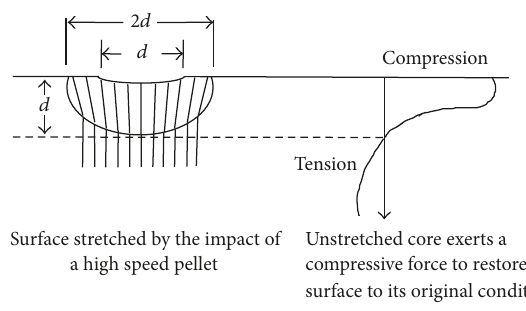
Figure2:Depthoftheresidualstressfieldproducedbyshotpeening [15].